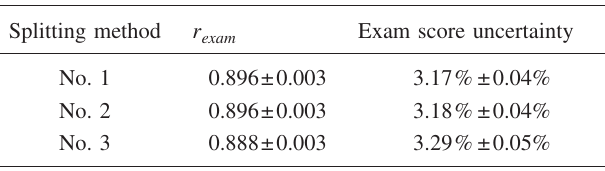
TABLE I. Estimated semester test reliability coefficients along with their corresponding test score uncertainties for the three meth- ods of splitting the semester’s set of exam questions. These values are for A+ to C− students only.